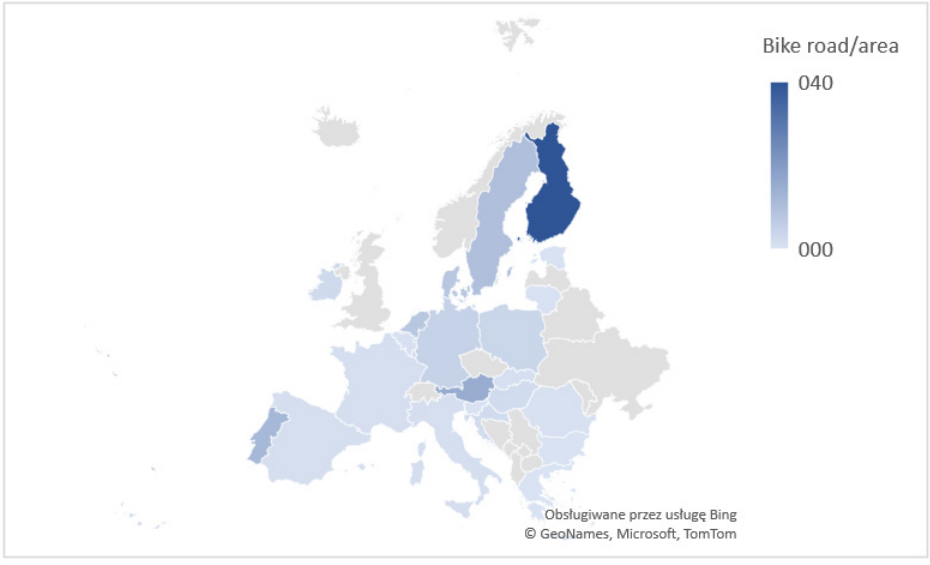
Figure 3. Bike road lengths per 1 km 2 in smart cities in European Union countries. Source: author’s analysis. Table 5. European countries—bike path saturation in the surveyed smart cities.